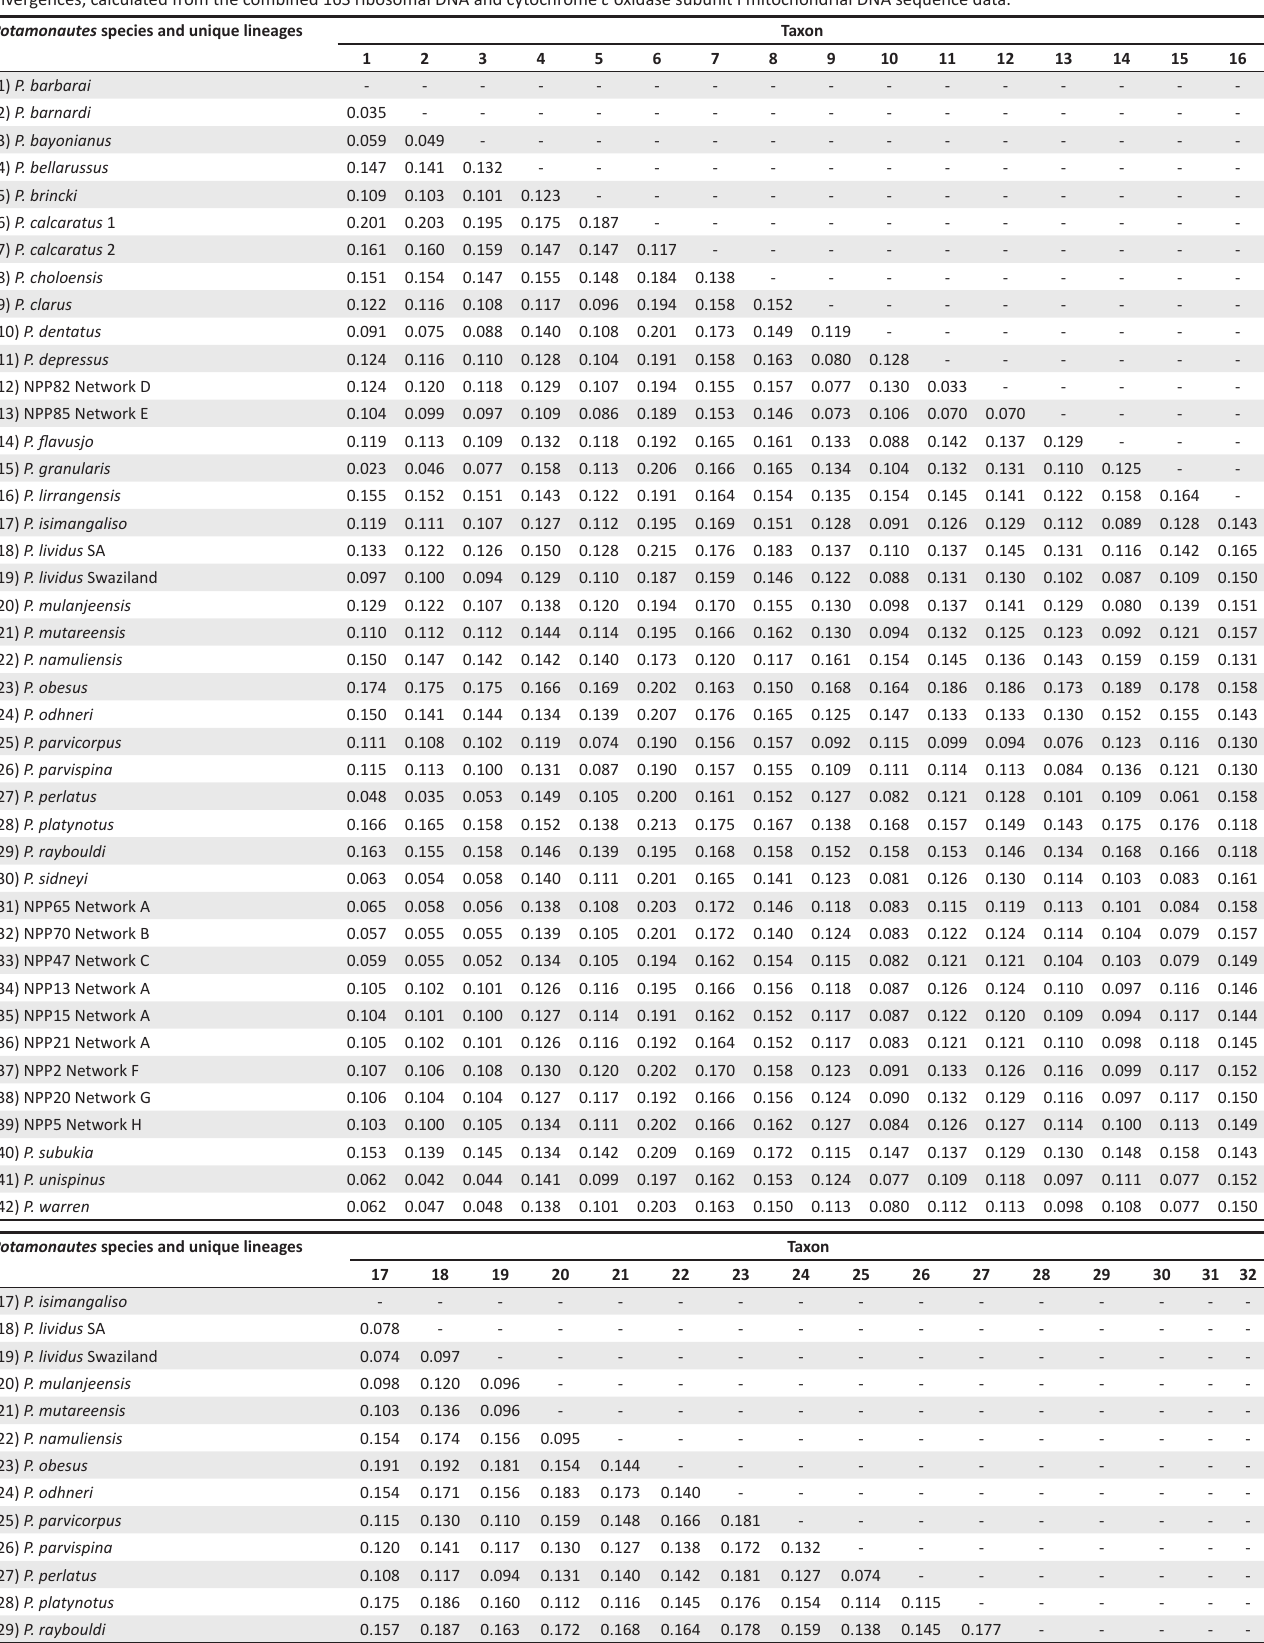
Table 1-A1 continues on the next page